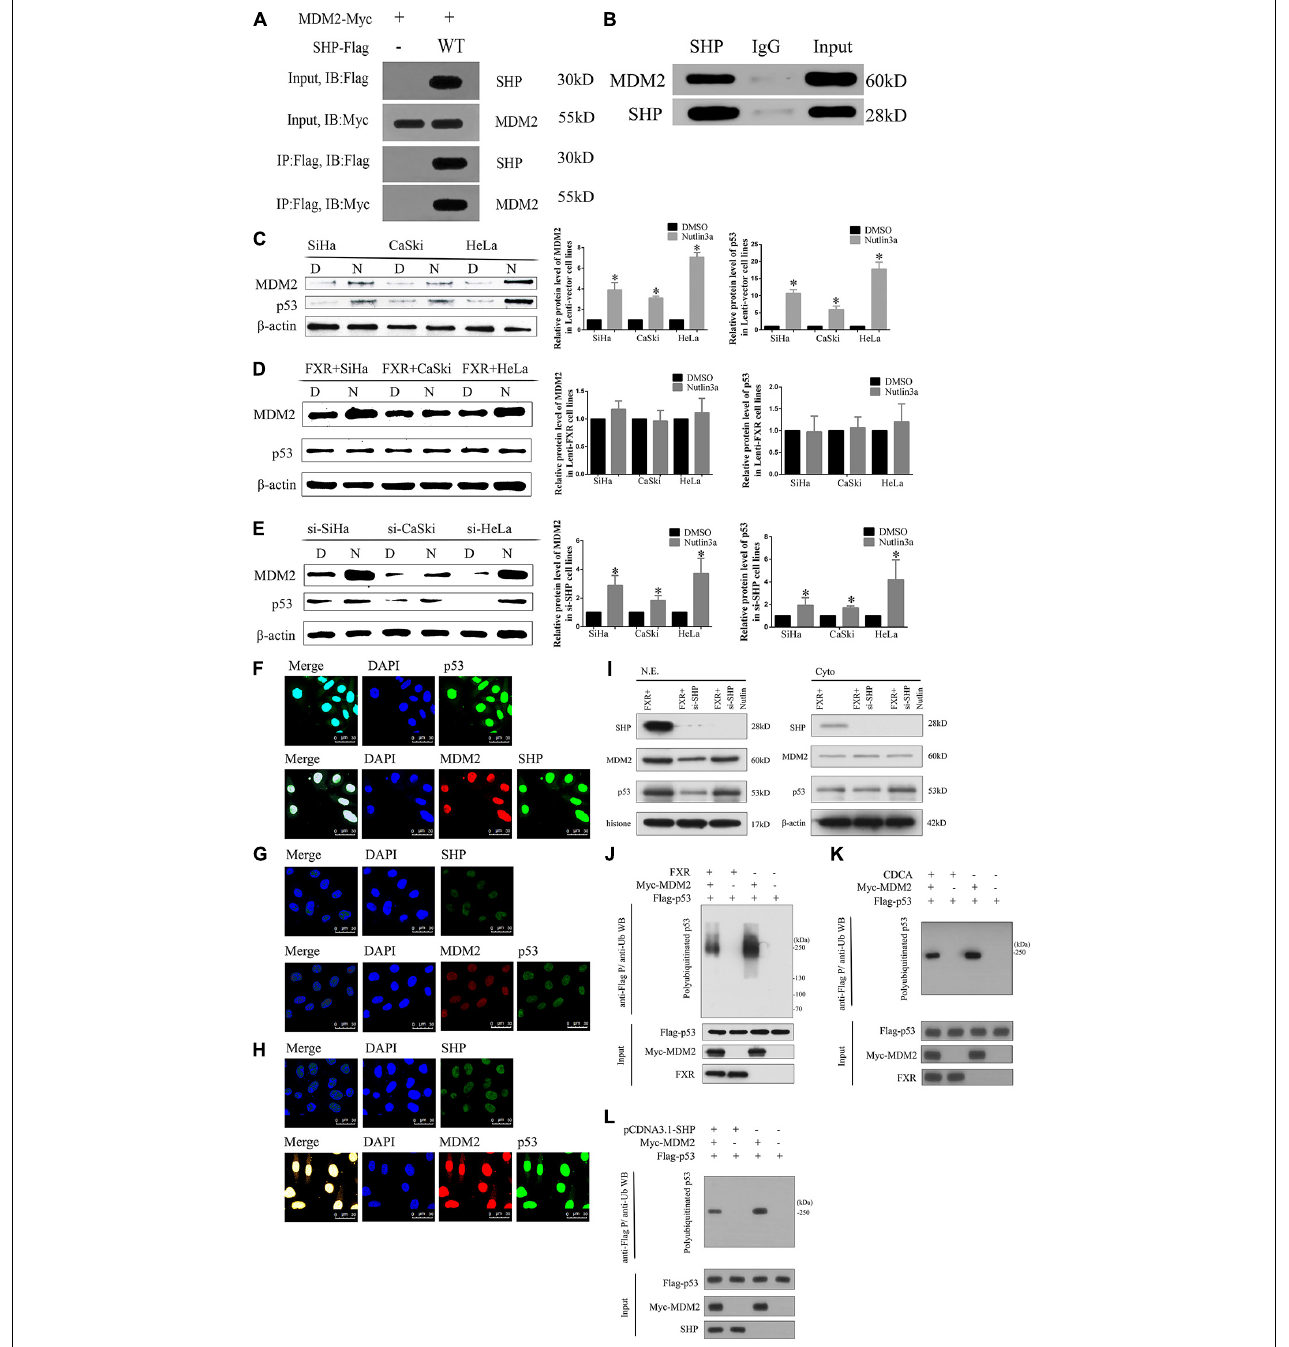
FIGURE 5 | FXR regulates p53 ubiquitination by stabilizing MDM2 aggregation in the nucleus through SHP. (A) Immunoprecipitation and western blot were performed to determine the association of SHP-WT with MDM2. An anti-Myc antibody was used to detect MDM2, and the anti-Flag antibody was used to IP SHP. (B) The MDM2 protein was immunoprecipitated with polyclonal anti-SHP antibodies in Lenti-FXR cells (IP: SHP), and immunoprecipitates were resolved by SDS-PAGE. Immunoblotting was performed with anti-MDM2 antibodies. Protein levels of MDM2 and p53 with or without application of Nutlin-3a were detected by western blot in Lenti-Vector cells (C) , Lenti-FXR cells (D) , and Lenti-FXR cells transfected with si-SHP (E) . D, DMSO; N, Nutlin3a. Immunofluorescent staining of SHP, MDM2, and p53 in SiHa-FXR cells (F) and counterparts co-transfected with si-SHP (G) or si-SHP and Nutlin-3a (H) . Nuclei (blue) are stained with 4 (cid:48) -6-diamidino-2-phenylindole (DAPI). (I) Nuclear and cytoplasmic extracts were obtained for immunoblot analysis of MDM2, p53, and SHP expression. (J) SiHa was co-transfected with Flag-p53 and Myc-MDM2; 48 h later, cells were treated with 10 µ mol/l MG132 for 2 h and harvested for immunoblot assay with anti-p53 antibody. The SiHa cells were transiently transfected with pCDNA3.1 (K) or cultured in the medium containing CDCA (50 µ mol/l) (L) . After 48 h, the protein ubiquitination was performed. ∗ P < 0.05 vs. DMSO group.